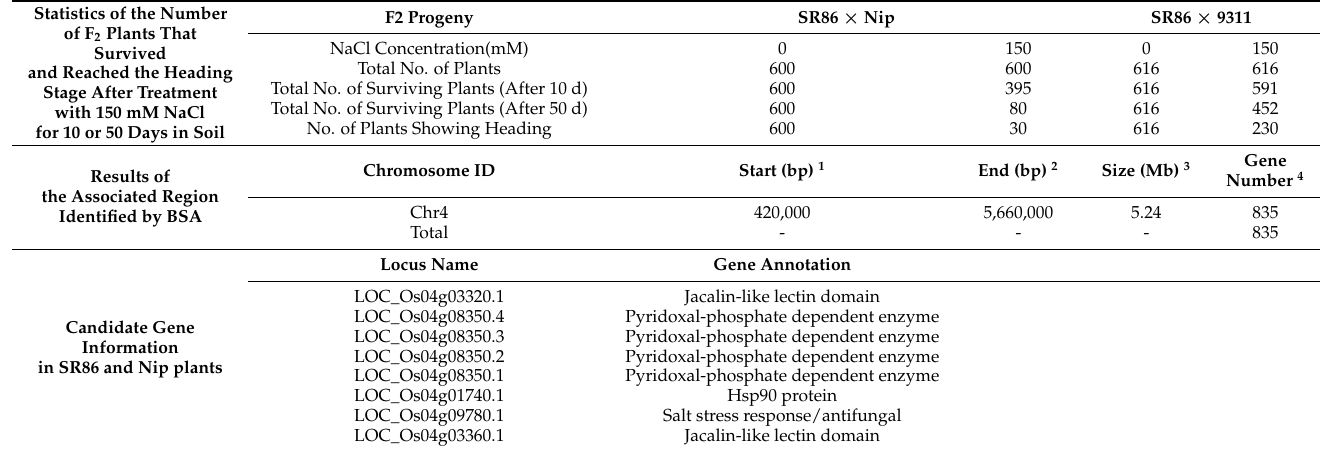
Table 1. The mapping and screening of salt tolerance candidate